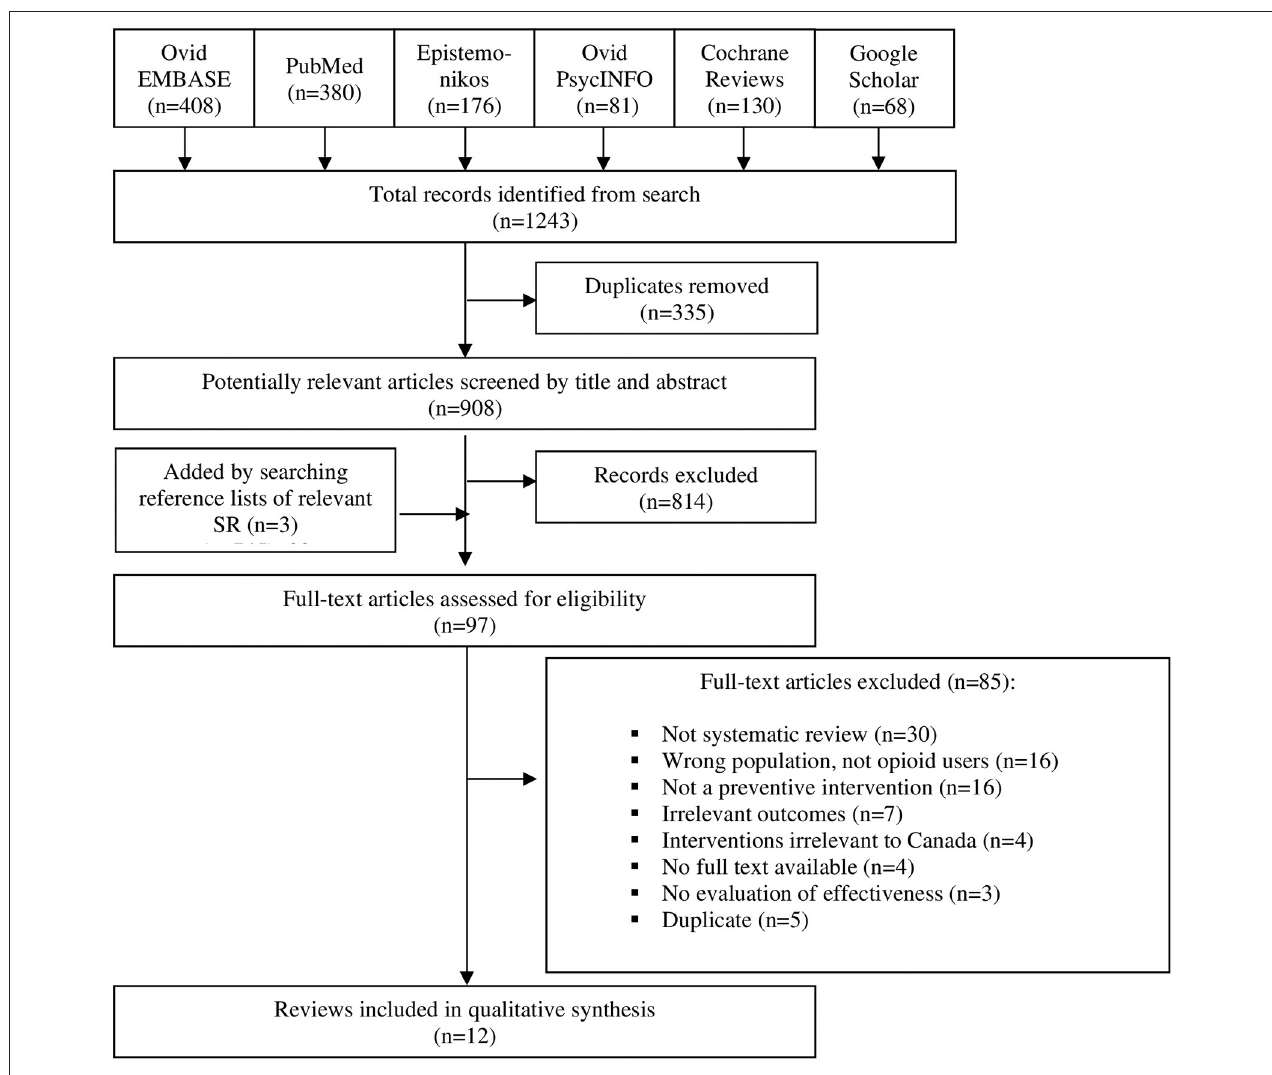
FIGURE 1 | Selection of papers, PRISMA flow